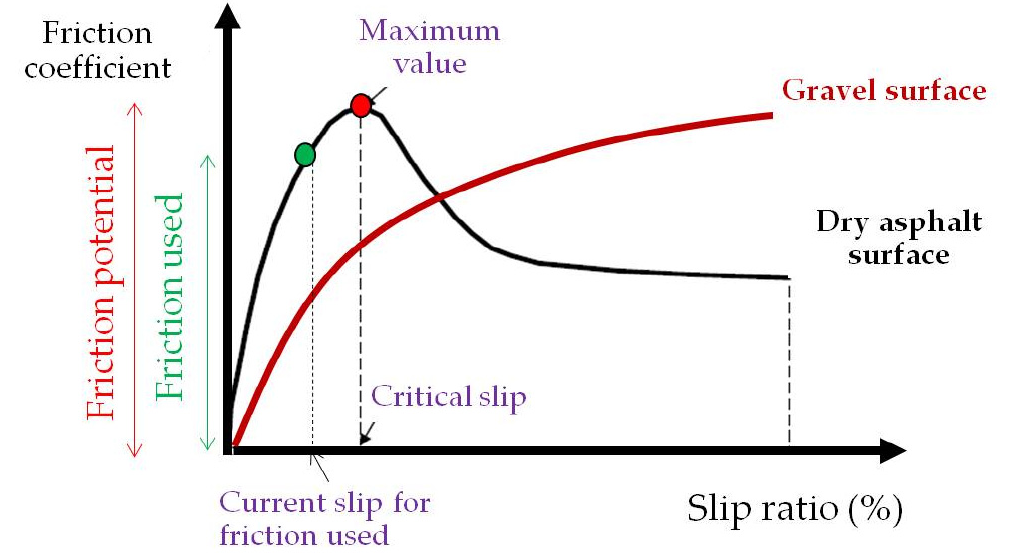
Figure 10. Friction versus longitudinal slip for differently paved surfaces (adapted from [45]).